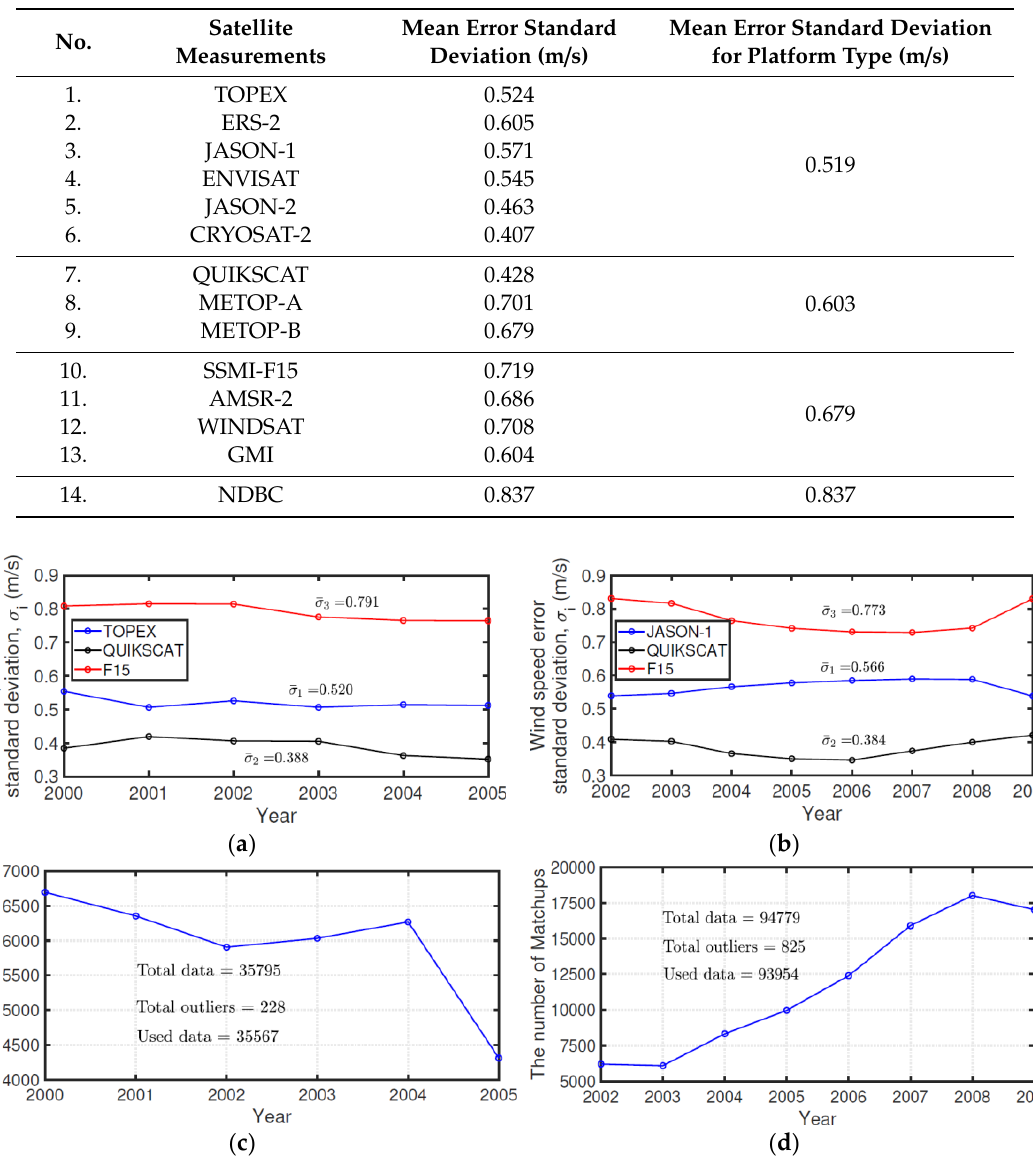
Table 2. Average random error standard deviations for measurement systems.